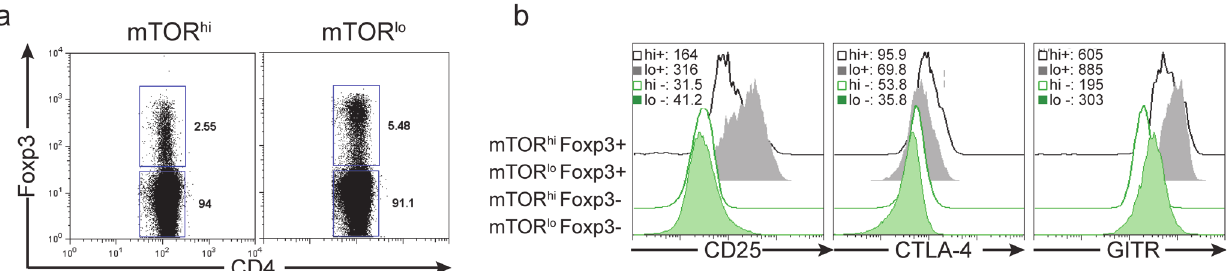
Fig 6. Foxp3+ CD4+ T cells generated from mTOR hi and mTOR lo sorted populations have distinct phenotypes. Splenocytes from 5c.c7 Rag – / — TCR transgenic mice were stimulated with 0.5ug/ml PCC peptide for 24hrs, and then sorted into CD4+CD69+ populations with FSC/SSC “ big ” mTOR hi or FSC/ SSC “ small ” mTOR lo profiles. Cells were cultured in media supplemented with IL-2 for 96hrs, and analyzed by flow cytometry. a) The percentage of CD4+ Foxp3+ cells was determined from each population. b) Histograms show shifts in MFI of markers associated with a T-reg phenotype. Populations were gated from the Foxp3+ or Foxp3- cells of the mTOR hi or mTOR lo sorted samples. The MFI of each protein is shown in the top corner of each FACs plot. The data are representative of at least 3 independent